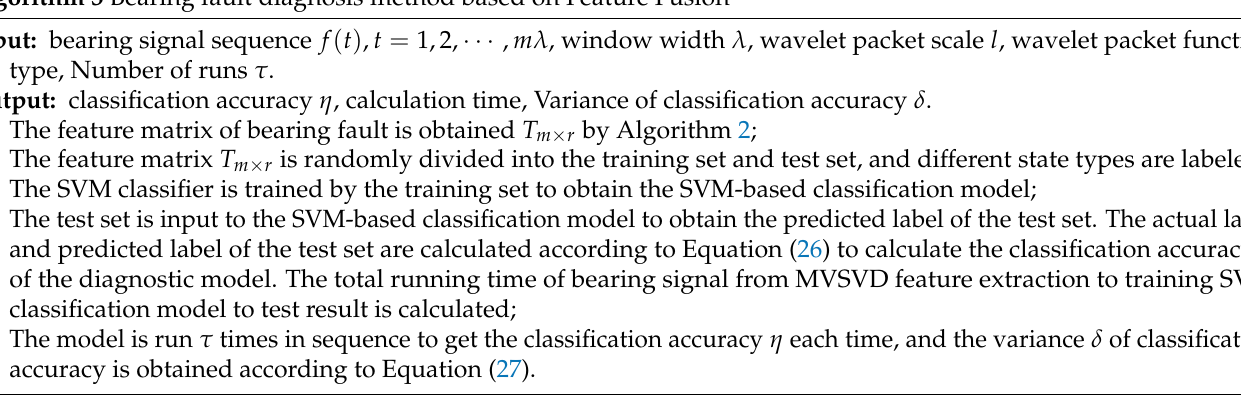
Algorithm 3 Bearing fault diagnosis method based on Feature Fusion